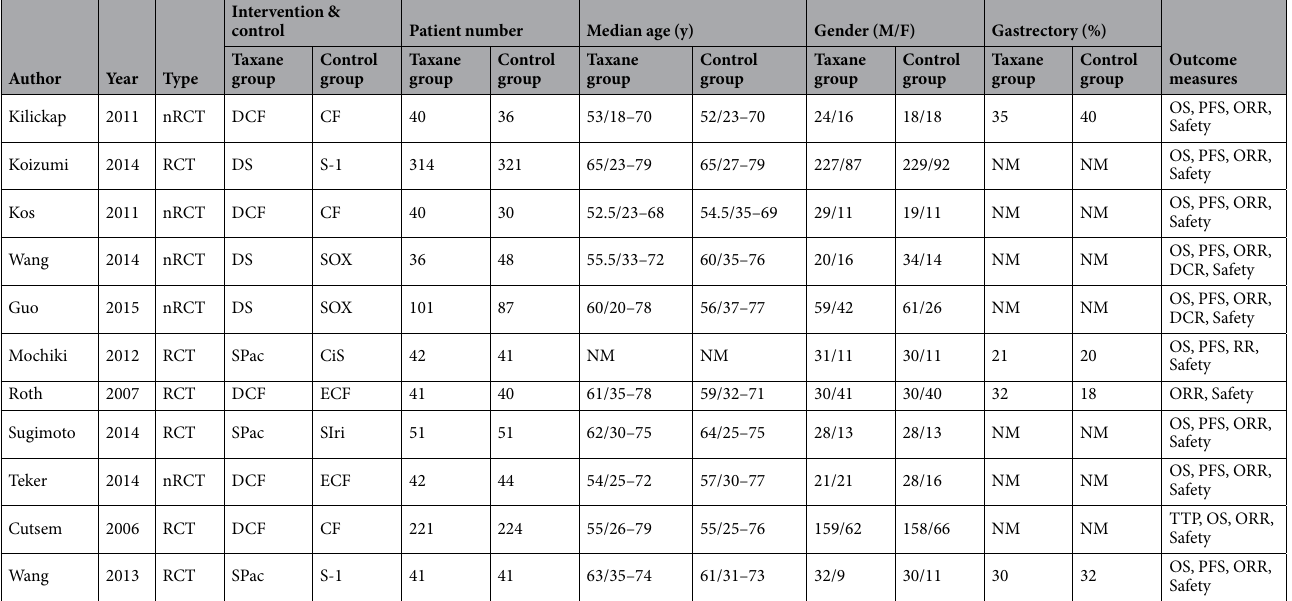
Table 1. Main characteristics of including studies. RCTs: randomized controlled trials, nRCT: non-randomized controlled trials. DCF: Docetaxle, Cisplatin and Fluorouracil; CF: Cisplatin and Fluorouracil; DS: Docetaxel and S-1; SOX: Oxaliplatin and S-1; SPac: Paclitaxel and S-1; CiS: Cisplatin and S-1; ECF: Epirubicin, Cisplatin and Fluorouracil; SIri: Irinotecan and S-1; NM: not mentioned; OS: overall survival; PFS: progression-free survival; ORR: overall response rate; DCR: disease control rate. The quality of RCT were assessed by the Cochrane risk of bias tool, and the quality of nRCT were assessed by Newcastle–Ottawa